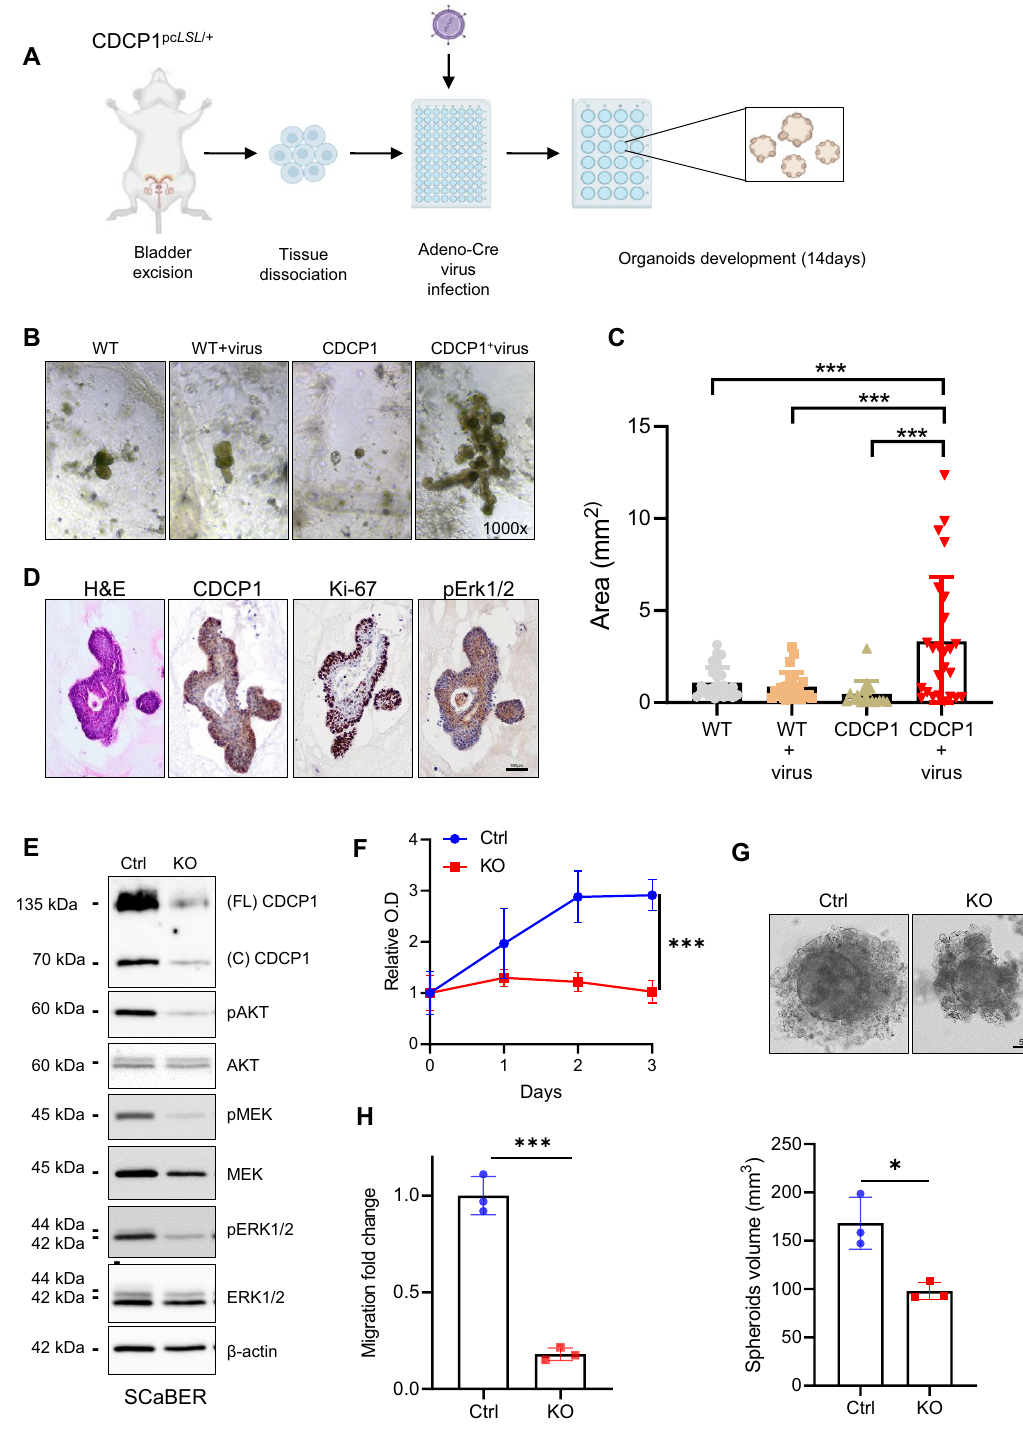
Figure 3. Transgenic overexpression of CDCP1 induces proliferation in ex vivo mouse organoids and its knockout inhibits proliferation and migration of UC cells. ( A ) Schematic representation of the generation of mouse organoids. ( B ) Representative images of the organoids generated from the C57BL/6 (WT) and transgenic (CDCP1) mice after 14 days of culture. The WT+ virus and the CDCP1+ virus conditions are transduced with the adeno-CRE virus. The WT and the CDCP1 conditions are processed as WT+ virus and CDCP1+ virus in the absence of the adeno-CRE virus. WT, WT+ virus and CDCP1 conditions are all controls. ( C ) Quantification of the approximate area of the organoids. Error bars indicate SD. ***P < 0.001. Statistical test: one-way analysis of variance. ( D ) Representative images of H&E and IHC (CDCP1, Ki67, p-ERK1/2) performed on the organoids. ( E ) Western blot analysis of CDCP1 and major downstream targets of CDCP1 signaling in SCaBER UC cell line (Ctrl) and its CDCP1 −/− counterpart (KO). ( F ) Relative O.D (proliferation) change of the CDCP1 expressing SCaBER cells (Ctrl) compared to the CDCP1 −/− (KO). Error bars indicate SD. ***P < 0.001. Statistical test: two-tailed unpaired t test. ( G ) Representative images of the spheroids originated from the CDCP1+ (Ctrl) and CDCP1 −/− (KO) SCaBER cells. Bar graphs show the quantification of the spheres volume. Error bars indicate SD. *P < 0.05. Statistical test: two-tailed unpaired t test. ( H ) Migration fold change of CDCP1 expressing SCaBER (Ctrl) compared to the CDCP1 −/− (KO). Error bars indicate SD. ***P < 0.001. Statistical test: two-tailed unpaired t